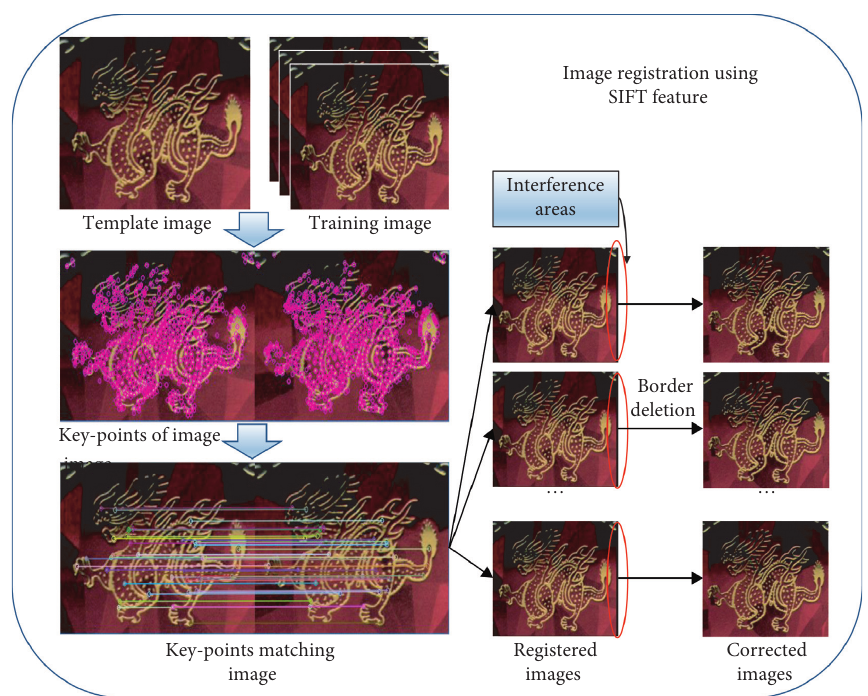
Figure 4: The architecture of image registration using SIFT